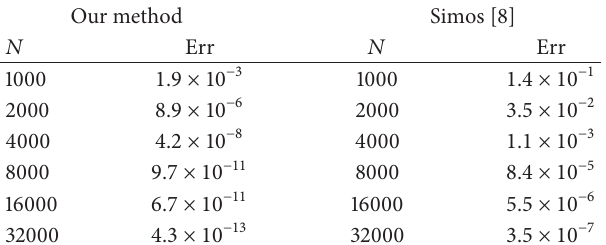
Figure 2: Efficiency curve for Example 1. Table 1: Results, with 𝜔 = 10 , for Example 1.